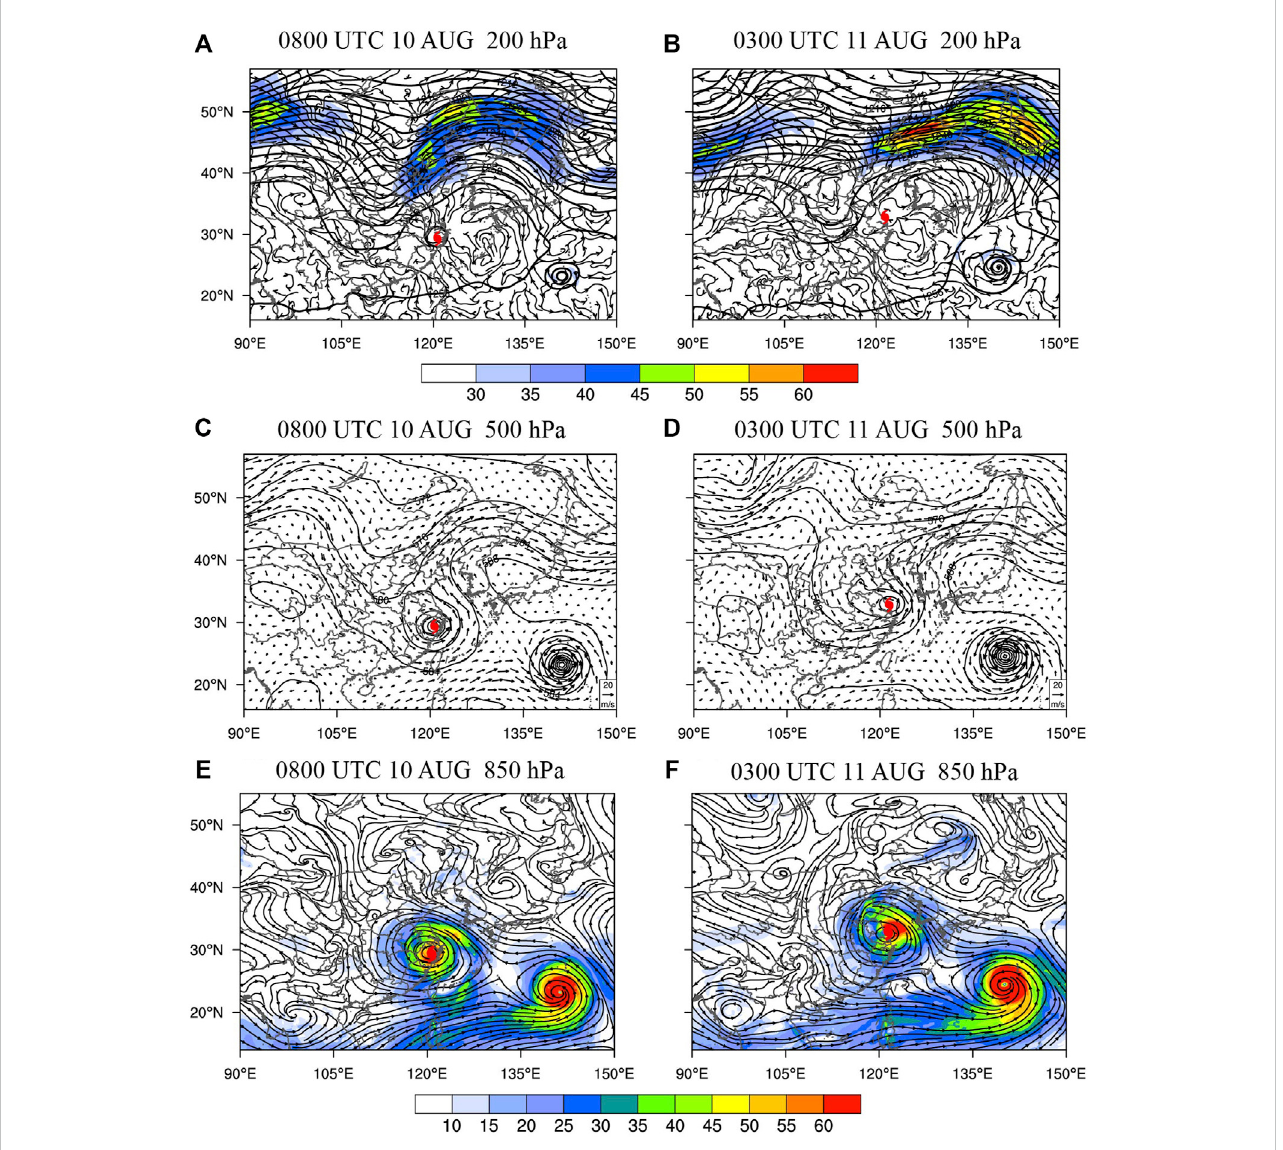
FIGURE 6 For 0800 UTC 10 August 2019, (A) the 200-hPa geopotential height (contours; unit: dagpm), horizontal wind speed (shaded; unit: m/s), and horizontal non-geostrophic winds (streamlines); (C) the 500-hPa geopotential height (contours; unit: dagpm) and horizontal winds (vectors, unit vector represents 20 m/s);and (E) the850-hPahorizontalwinds(streamlines)andhorizontalwatervapor fl ux(shaded;unit:kg/(hPa · m · s))fromtheD01simulation. (B) , (D) , (F) as in (A) , (C) , (E) , but at 0300 UTC 11 August. Typhoon symbols indicate the locations of Lekima ’ s